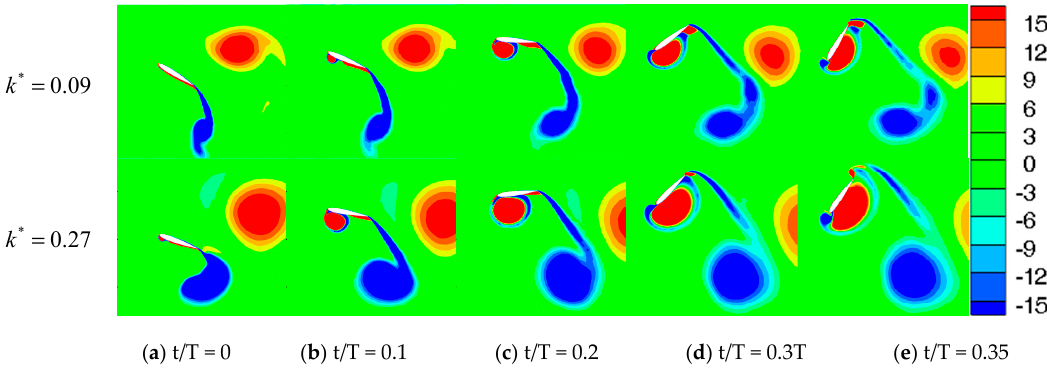
( d ) Figure 12. Evolution of (a) the thrust coefficient, (b) the lift coefficient, (c) the moment coefficient, and (d) the pitching profile for 𝑘 ∗ = 0.09,0.27,0.37 , 𝑦 (cid:2868) = 0.2 , 𝑓 ∗ = 0.17 . To further understand the influence of the torsion spring stiffness on the flow around the